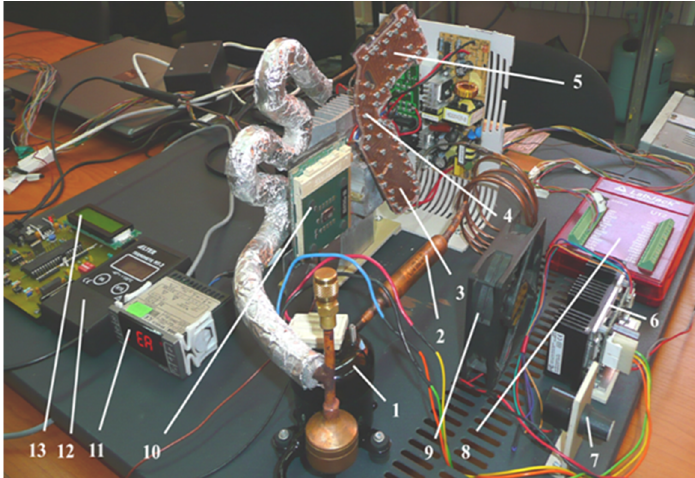
Figure 1. Image of the experimental setup: 1—ASPEN rotary compressor; 2—filter; 3—condenser; 4—lamination tube; 5—evaporator; 6—driver; 7—rotary switch used to adjust the speed; 8—LabJack U12 interface; 9—cooler; 10—CPU with a heat source located on the back side, not visible in the image; 11, 12, 13—thermometers.